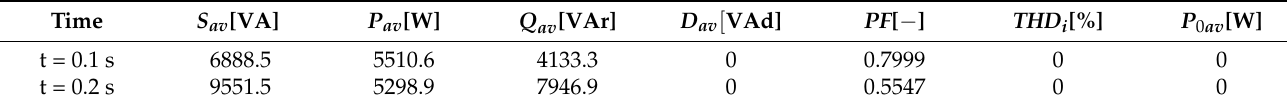
Table 4. Simulation results before and after the change (at steady states).